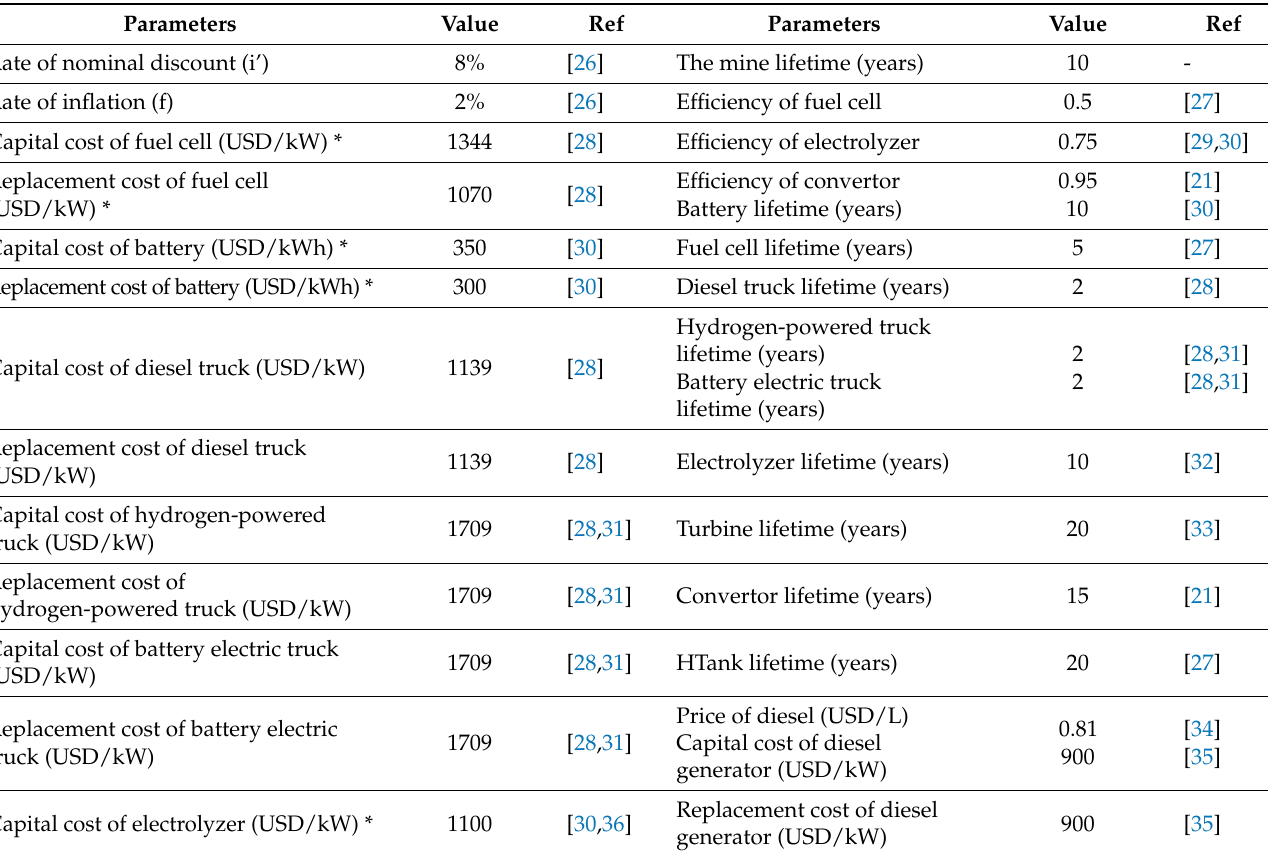
Table 2. Parameters used for the